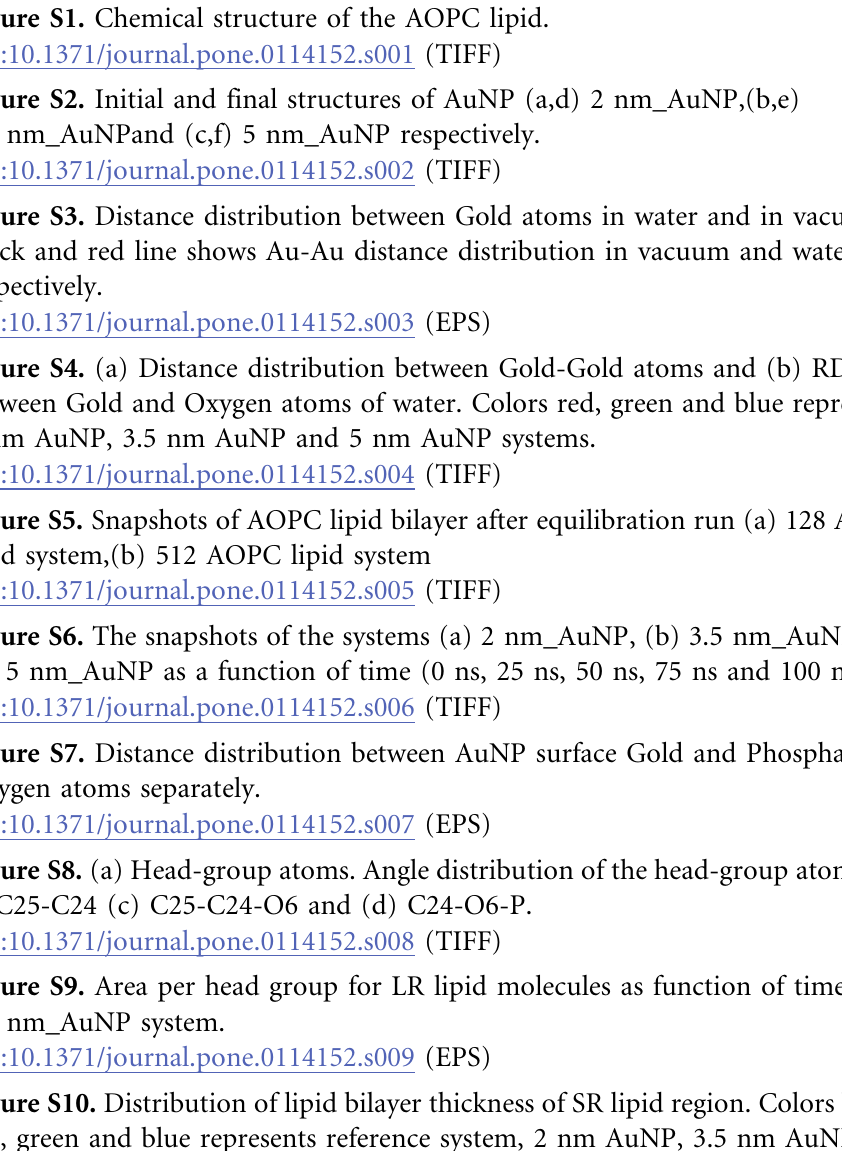
Figure S1. Chemical structure of the AOPC lipid. doi:10.1371/journal.pone.0114152.s001 (TIFF) Figure S2. Initial and final structures of AuNP (a,d) 2 nm_AuNP,(b,e) 3.5 nm_AuNPand (c,f) 5 nm_AuNP respectively. Figure S3. Distance distribution between Gold atoms in water and in vacuum. Black and red line shows Au-Au distance distribution in vacuum and water respectively. Figure S4. (a) Distance distribution between Gold-Gold atoms and (b) RDF between Gold and Oxygen atoms of water. Colors red, green and blue represents 2 nm AuNP, 3.5 nm AuNP and 5 nm AuNP systems. Figure S5. Snapshots of AOPC lipid bilayer after equilibration run (a) 128 AOPC lipid system,(b) 512 AOPC lipid system doi:10.1371/journal.pone.0114152.s005 (TIFF) Figure S6. The snapshots of the systems (a) 2 nm_AuNP, (b) 3.5 nm_AuNP and (c) 5 nm_AuNP as a function of time (0 ns, 25 ns, 50 ns, 75 ns and 100 ns). doi:10.1371/journal.pone.0114152.s006 (TIFF) Figure S7. Distance distribution between AuNP surface Gold and Phosphate Oxygen atoms separately. Figure S8. (a) Head-group atoms. Angle distribution of the head-group atoms (b) N-C25-C24 (c) C25-C24-O6 and (d) C24-O6-P. doi:10.1371/journal.pone.0114152.s008 (TIFF) Figure S9. Area per head group for LR lipid molecules as function of time for 3.5 nm_AuNP system. Figure S10. Distribution of lipid bilayer thickness of SR lipid region. Colors black, red, green and blue represents reference system, 2 nm AuNP, 3.5 nm AuNP and 5 nm AuNP systems respectively. Figure S11. Lateral mean square displacement of AOPC lipids from last 20 ns with 2 ns interval of each. Black solid line represents average MSD of all